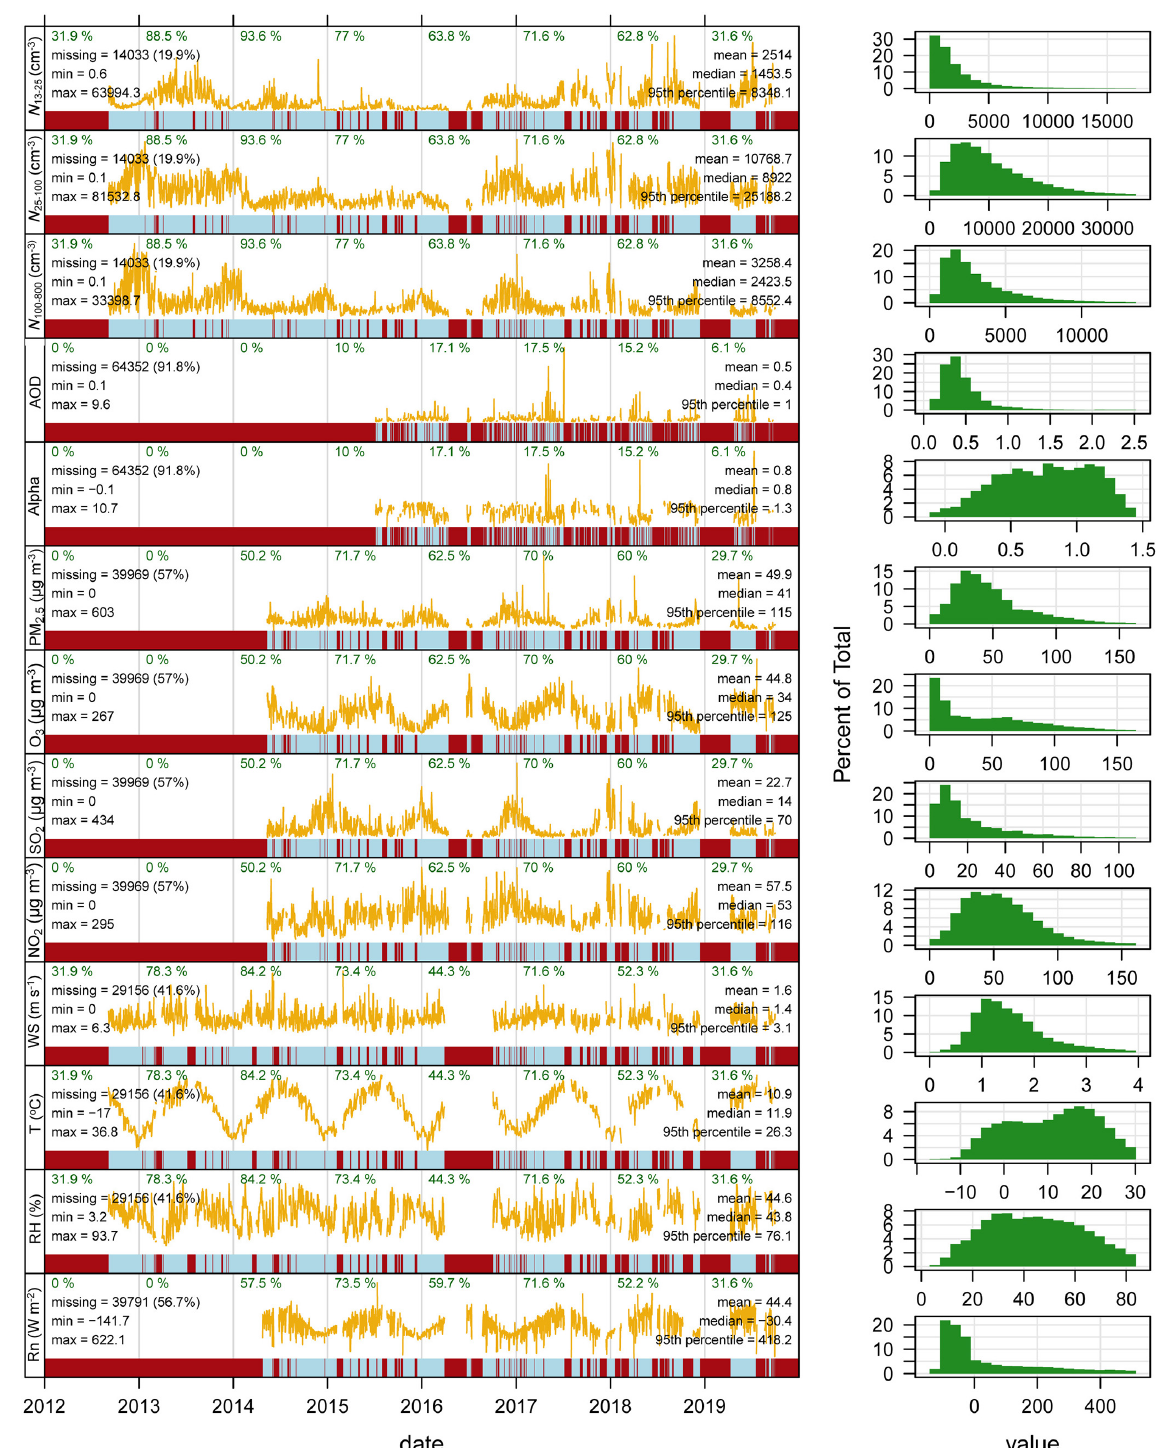
Figure 2. Time series of daily average particle number in the three modes ( N 13 − 25 , N 25 − 100 and N 100 − 800 ), aerosol optical properties (AOD, Alpha), the criteria air pollutants (PM 2 . 5 , O 3 , SO 2 , NO 2 ), and basic meteorological parameters and the corresponding probability density functions in urban Lanzhou during the campaign. The frequencies of missing values and the statistics are shown in each subplot. T , RH and R n represent temperature, relative humidity and net radiation,